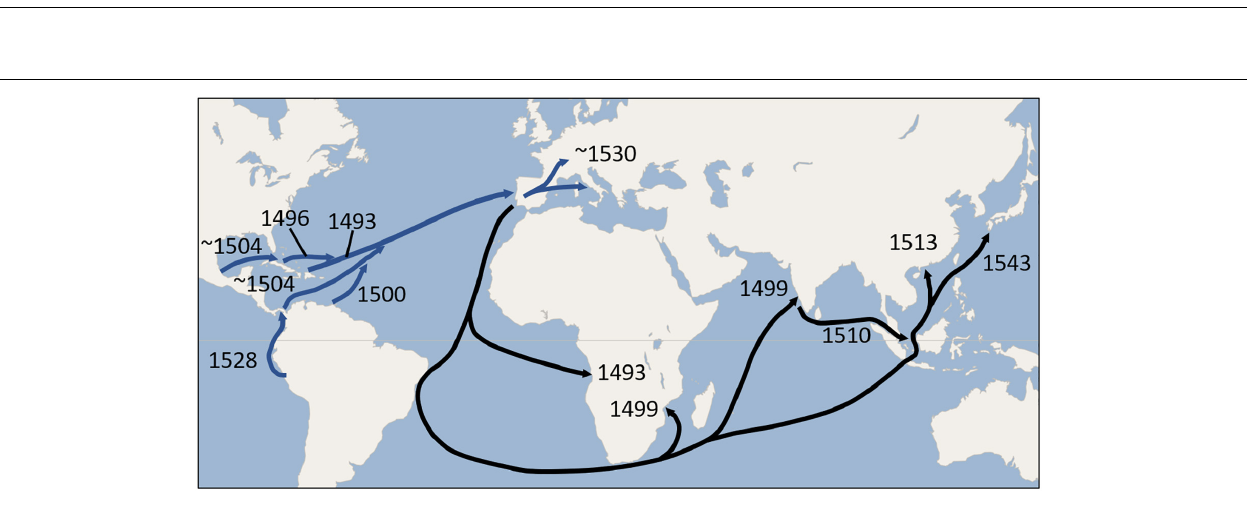
Frontiers in Plant Science |